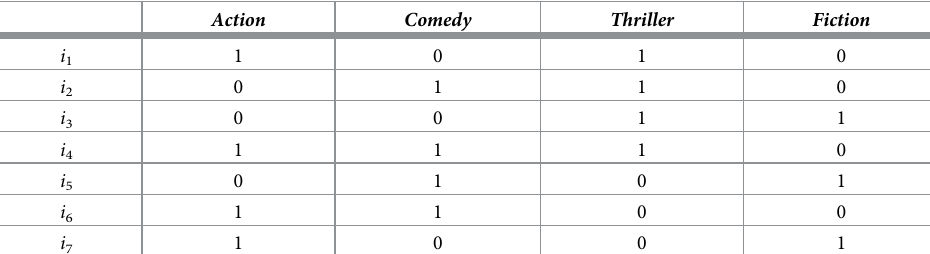
computation between users in cluster 1 and cluster 2 is presented in Tables 7 and 8, respec- tively. The similarity between user u and v in a cluster c is computed using Eq (7), i.e., by tak- ing the product of Pearson Similarity between u and v , and membership of v in cluster c .